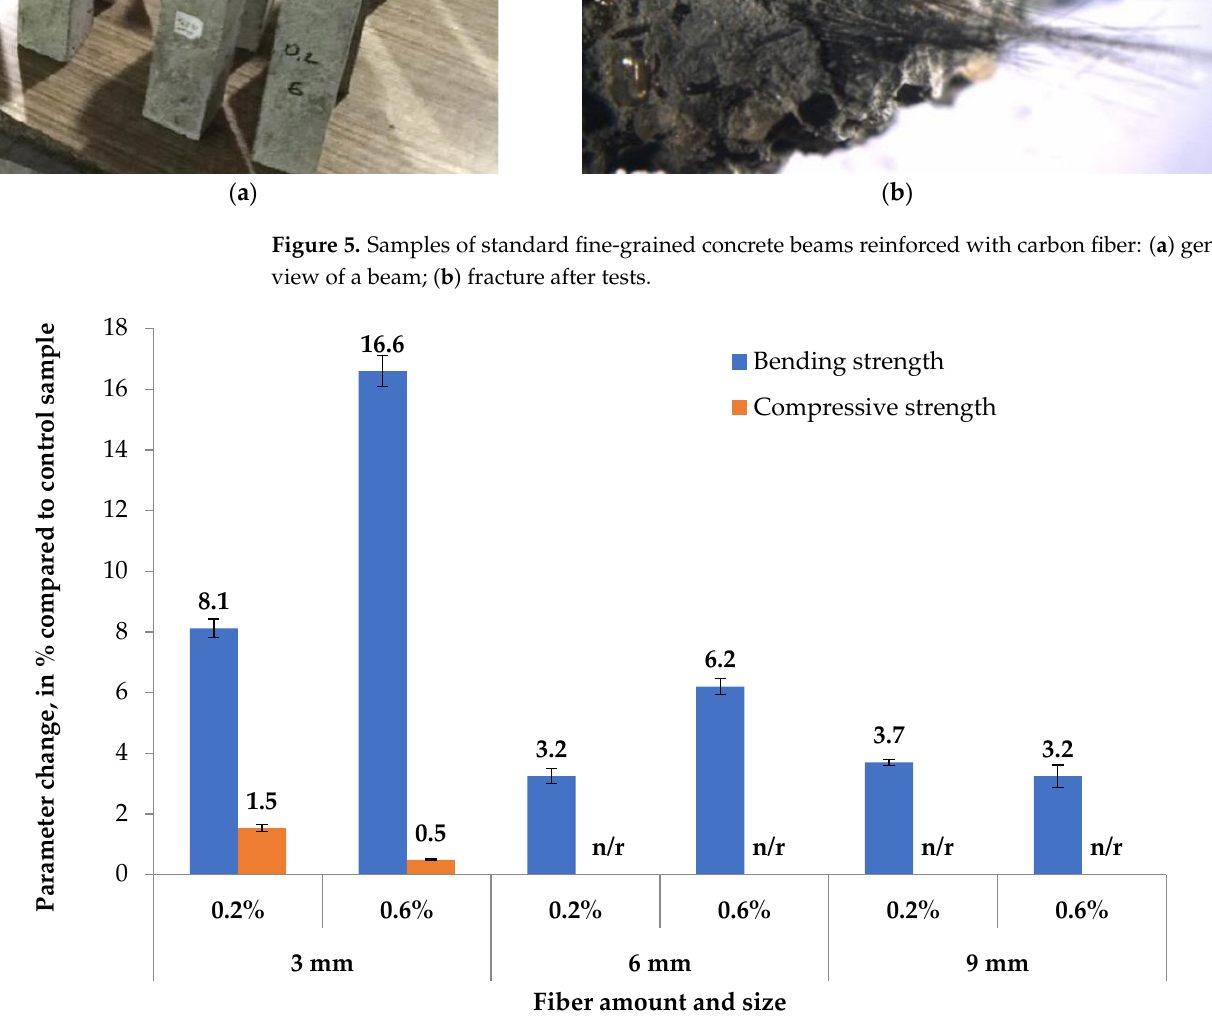
Figure 6. Changes in fracture size and bending strength of concrete blocks in comparison with the control sample (without the addition of fibers); n/r — negative results.